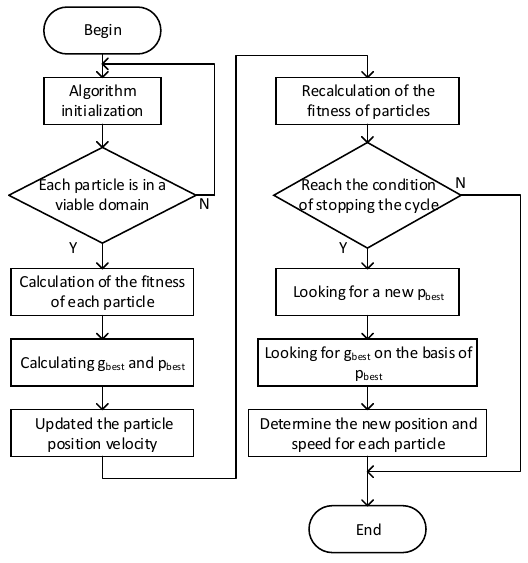
Figure 3. algorithm calculation flow chart.